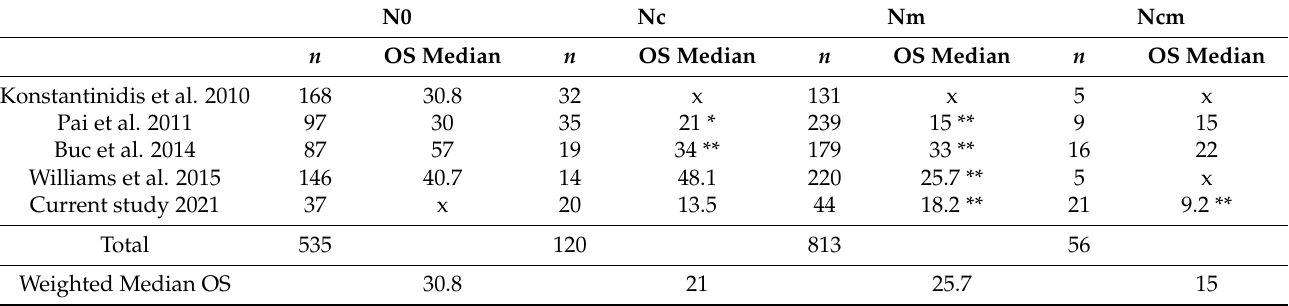
Modified table of Williams et al. [10]: N0: node negative; Nc: direct node invasion; Nm: regional lymph node metastasis; Ncm: mixed node invasion; x: not calculated. * Significant difference with Nm. ** Significant difference with N0. The latest study of Byun et al. was excluded as they calculated only disease-free survival, as were the results of Hoshikawa et al. [11], as they built groups of single lymph nodes and distinguished further